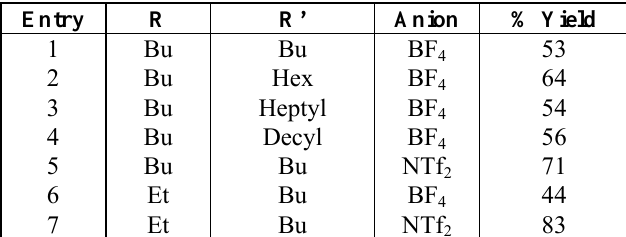
Table 2 . Metathesis Reaction